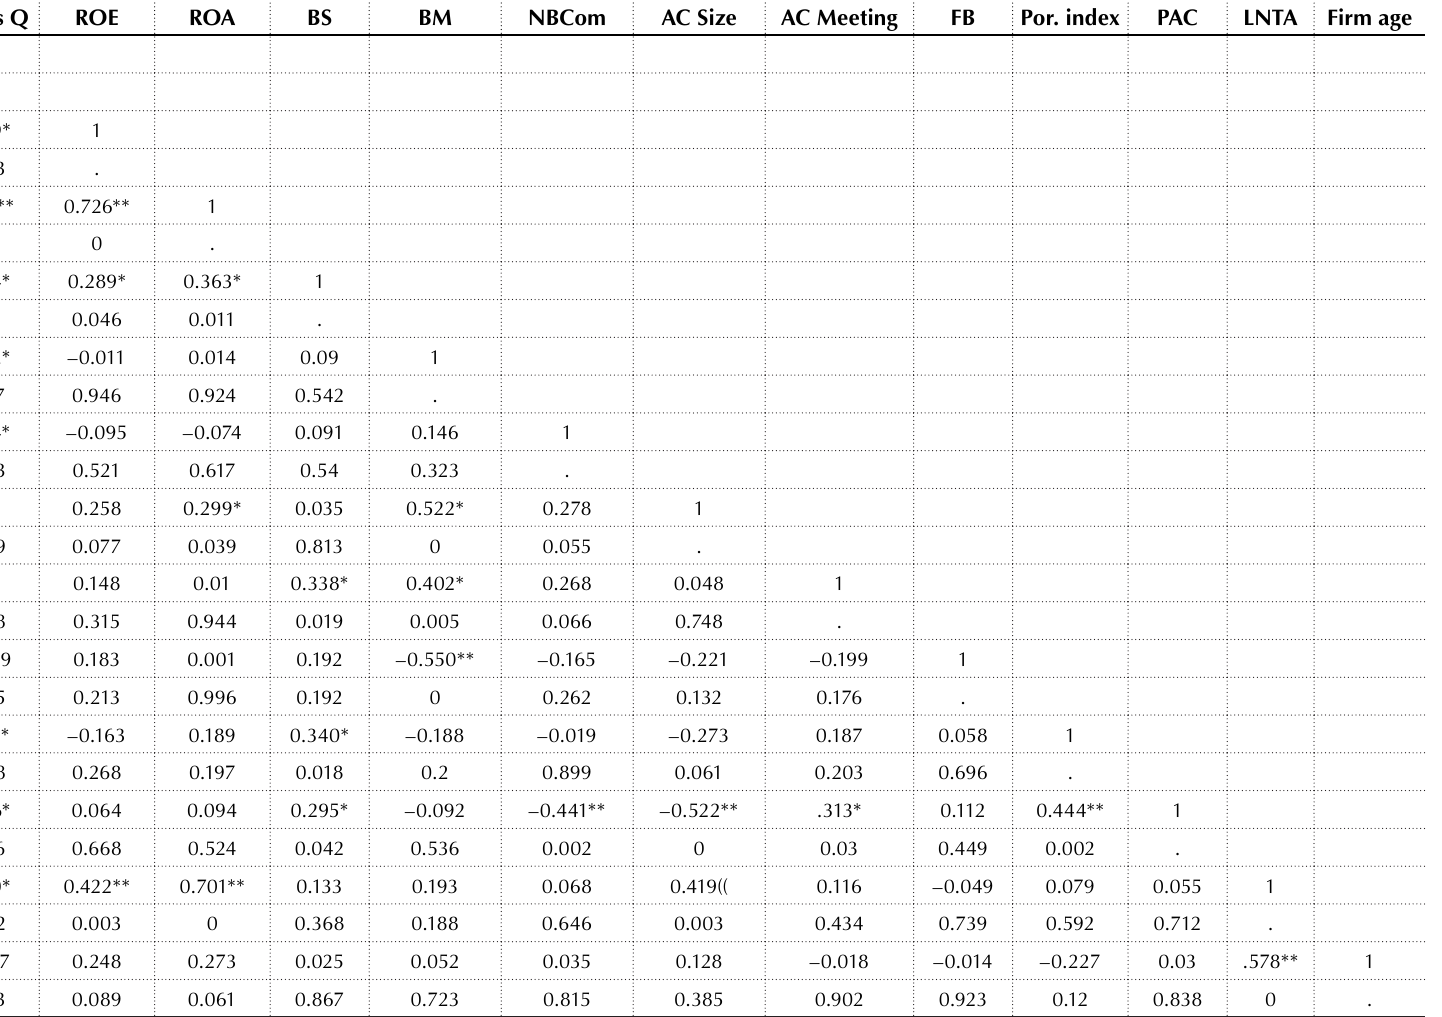
Table 4. Pearson correlation analysis, N = 48, significance (two-tailed) Tobin’s